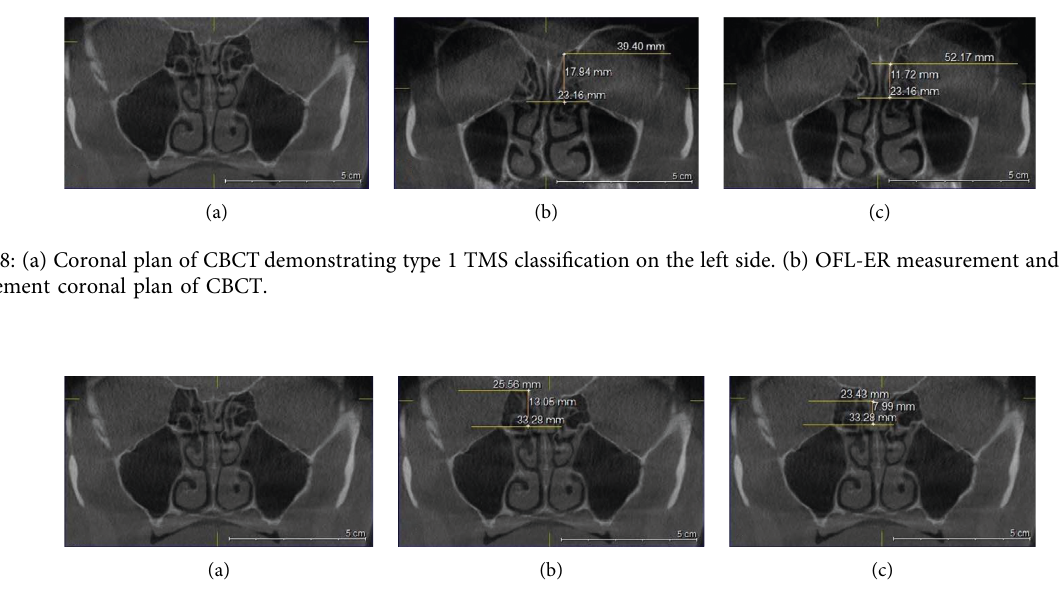
Figure 9: (a) Coronal plan of CBCTdemonstrating type 2 TMS classification on the right side. (b) OFL-ER measurement and (c) OFL-CP measurement coronal plan of CBCT.